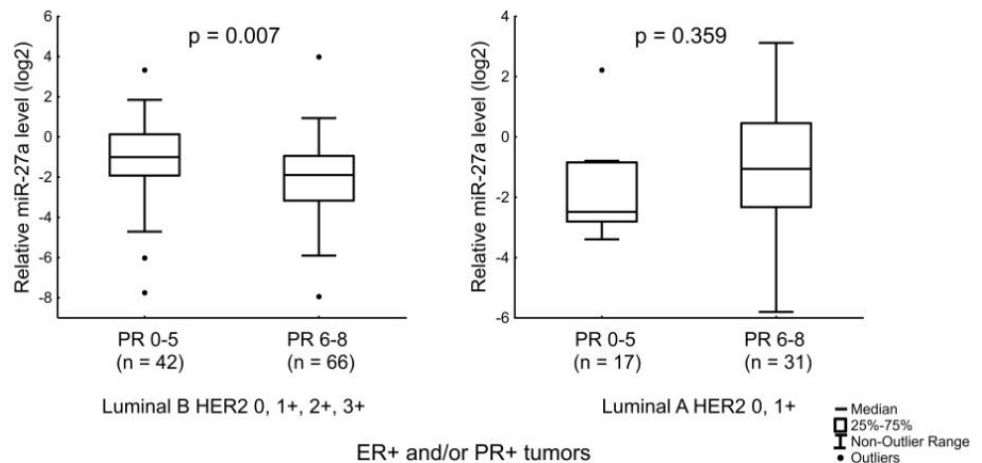
Figure 4. Relation of miR-27a level with PR expression level in luminal B tumors (left) and relation of miR-27a level with PR expression level in luminal A tumors (right). The Y axis presents the expression level (log 2 – ∆∆ Ct ); the results were normalized to the control (normal tissue).